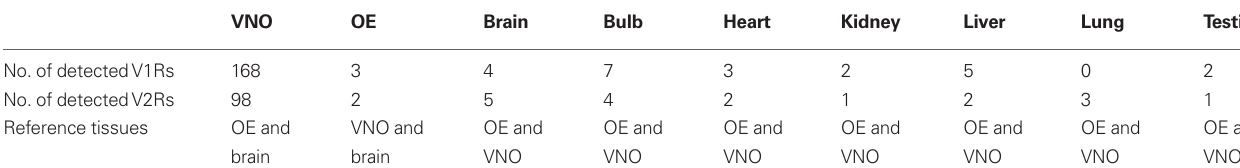
Table S1 | Summary of detected mouse VR genes in nine tested tissues.